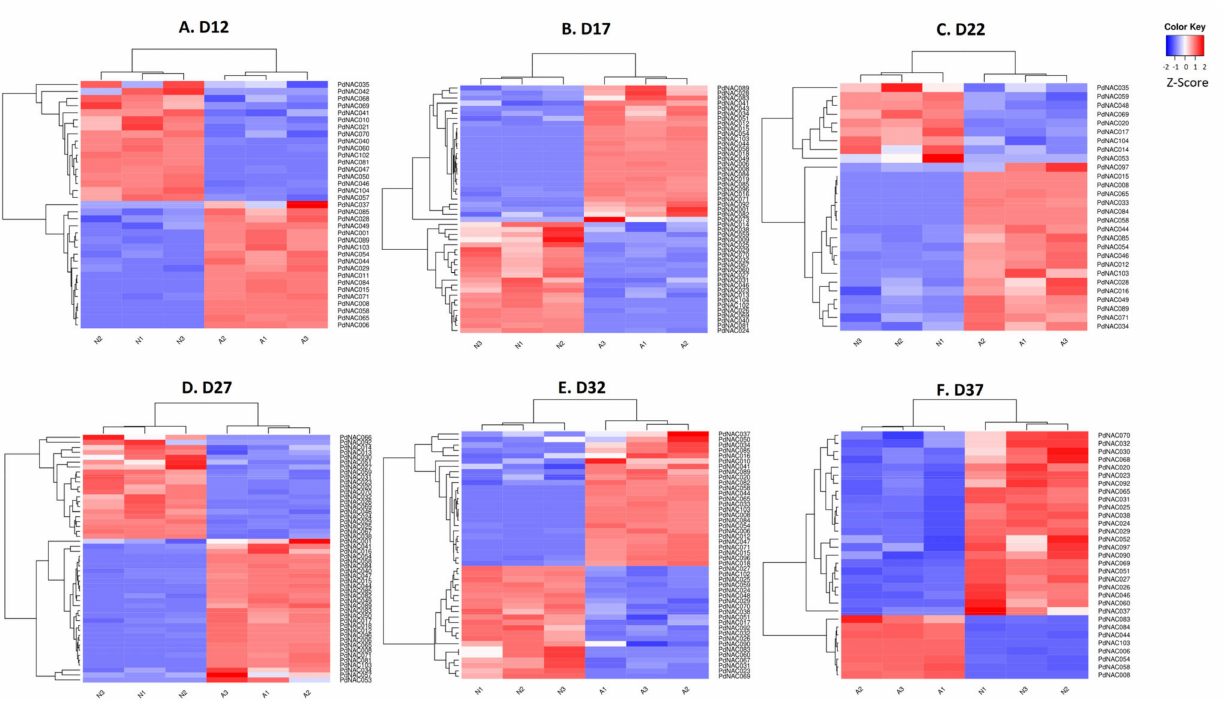
Figure 10. Differential gene expression. Heatmaps of differential gene expression of PdNAC in almond fruit is shown at developmental stage D12 ( A ), D17 ( B ), D22 ( C ), D27 ( D ), D32 ( E ), and D37 ( F ). Heatmaps are based on